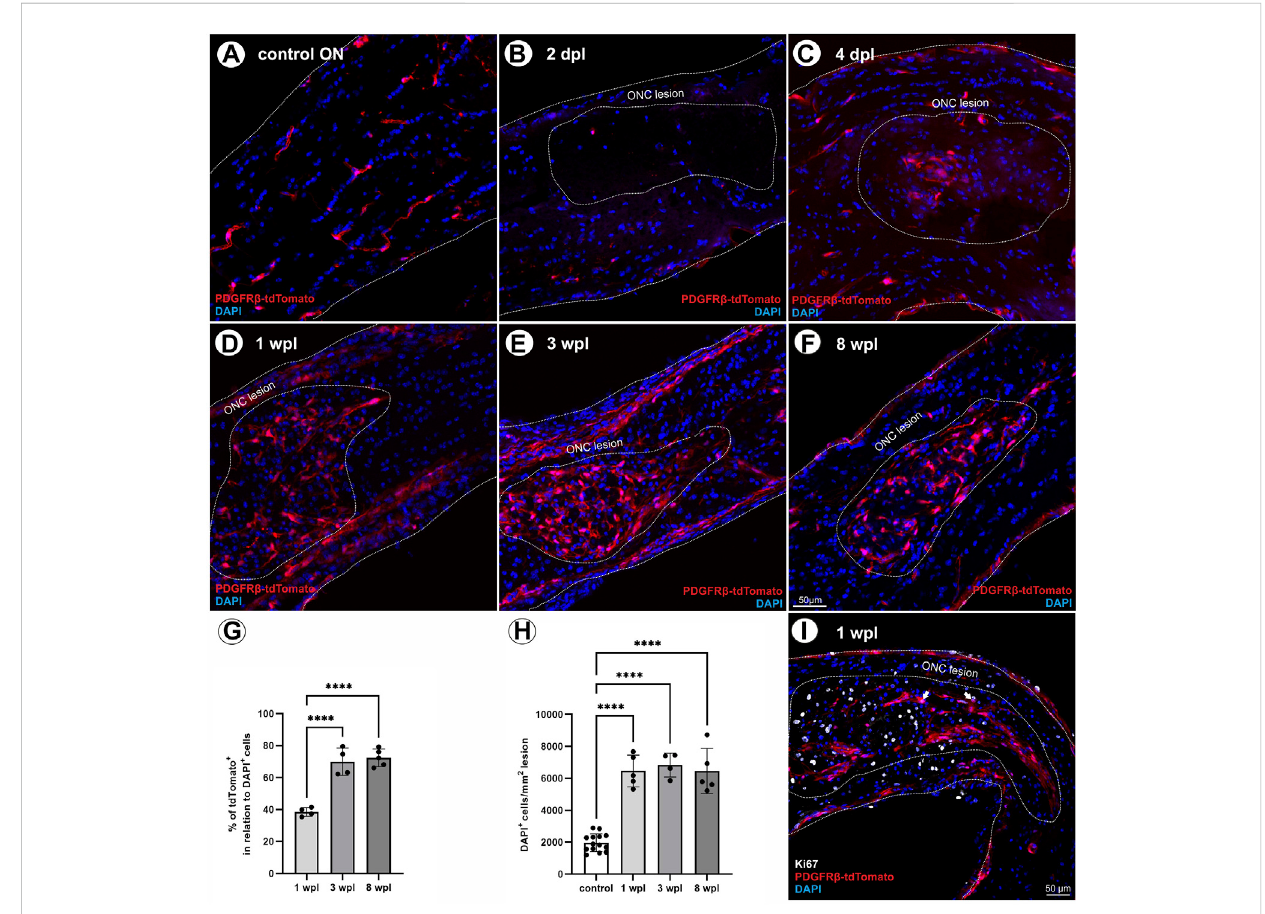
FIGURE 3 LocalizationoftdTomato+cellsinthelesionareaovertime. (A) IncontrolONs,tdTomato + cells(red)aremainlyassociatedtovascularstructures. (B) At 2 dpl, a nearly cell-free region is detected at the site of ONC. (C) At 4 dpl, a small hypercellular region is visible within the lesion, including also tdTomato + cells ( n = 5). (D) At 1 wpl ( n = 9), (E) 3 wpl ( n = 4), and (F) 8 wpl ( n = 7), tdTomato + cells were detected evenly distributed in the lesion area. (G) ThenumberoftdTomato + cellsinrelationtoDAPI + cellswithinthelesion. (H) ThenumberofDAPI + cellsincontrolONsincomparisontoDAPI + cells within the lesioned area at 1 wpl, 3 wpl, and 8 wpl. (I) At 1 wpl, the proliferation marker Ki67 is detected within the lesion, revealing just sporadic co- localization with TdTomato + cells ( fi lled arrows, n = 3). (A – F) Representative images; the ONC lesion is marked by the dotted line. Signi fi cance was calculated by one-way ANOVA and Tukey ’ s multiple-comparison test; * p < 0.05, ** p < 0.01, *** p < 0.001, and **** p <